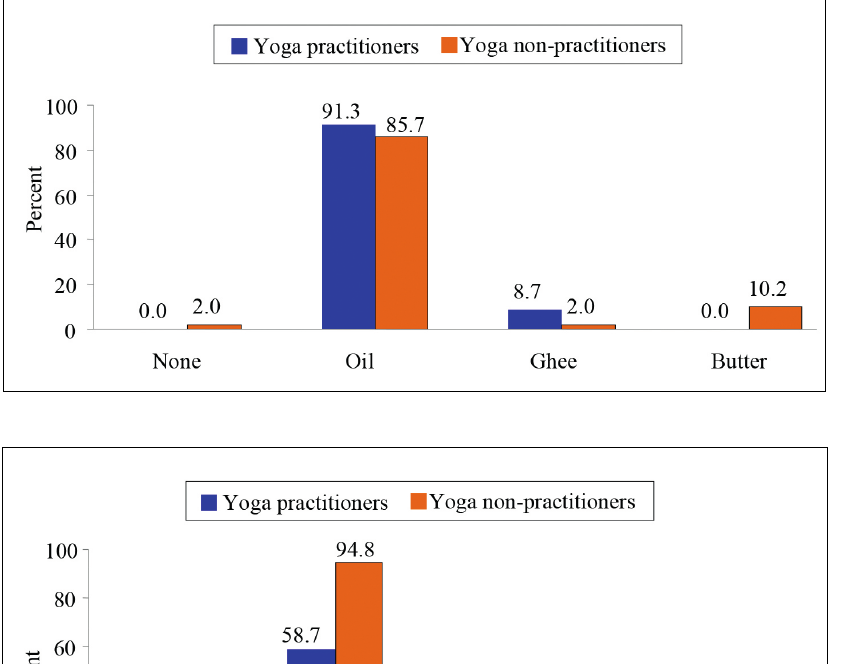
Figure 3. Pattern of fat intake in